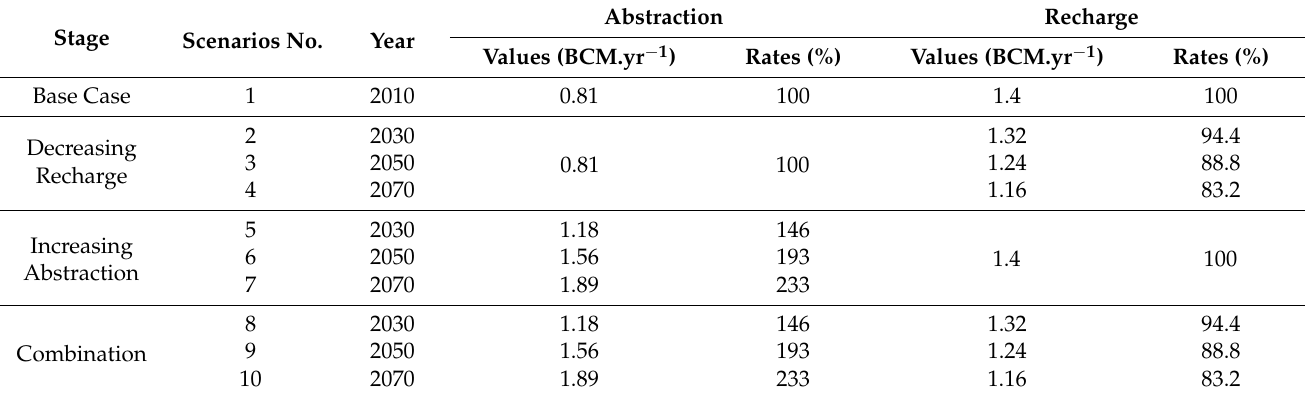
Table 1. Proposed scenarios of different GW abstraction and surface recharge